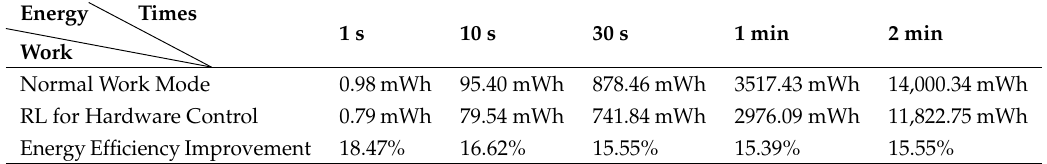
Table 3. Energy efficiency evaluation.